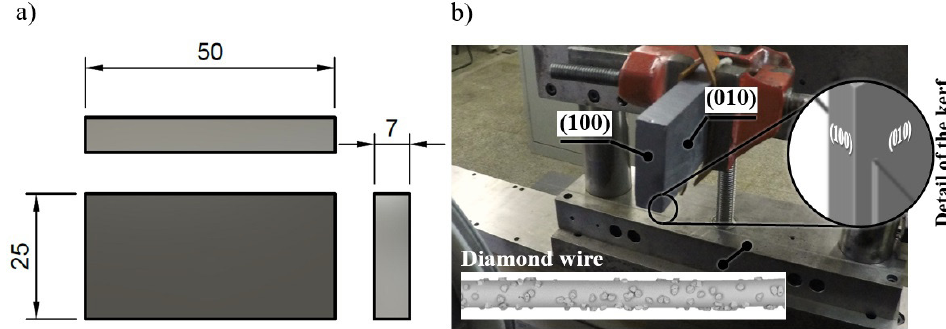
Figure 4. Mono-Si workpiece: a) dimensions (mm); b) crystallographic orientation in function of the wire cutting direction.